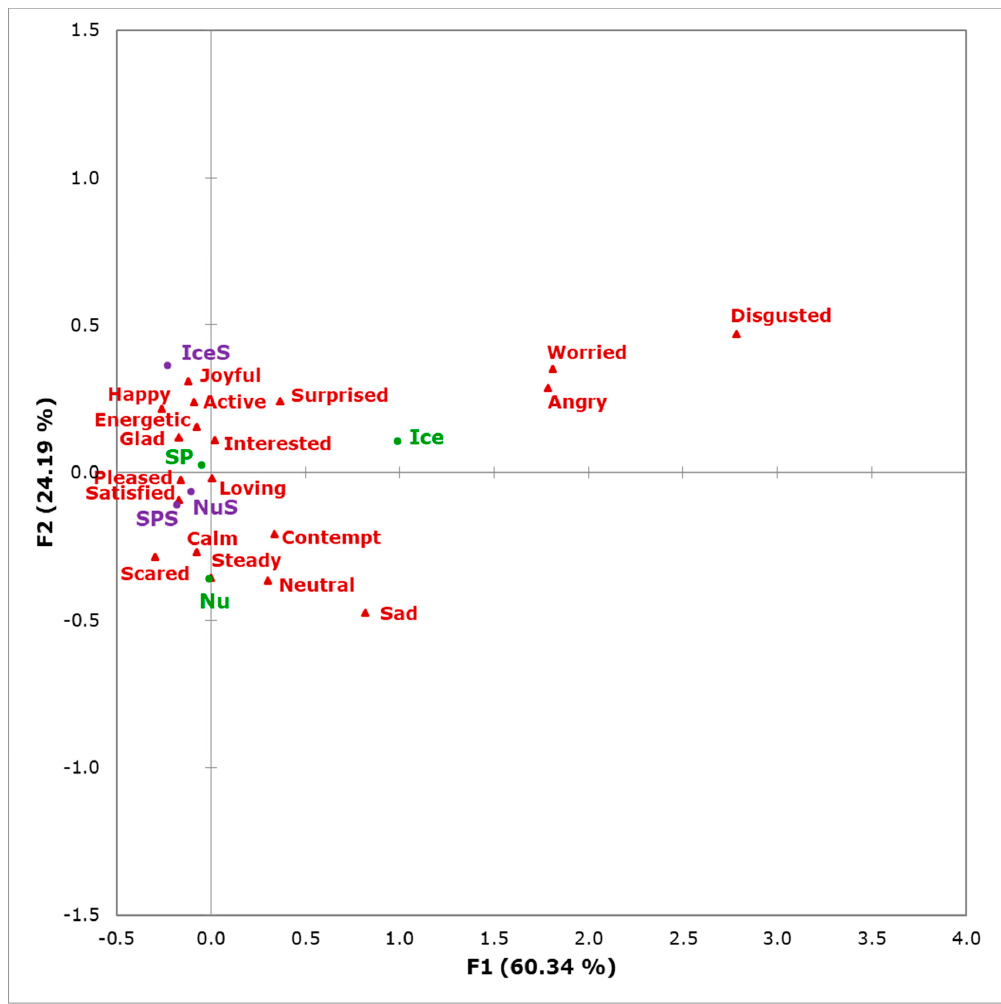
Figure 7. Correspondence analysis of the visual assessment showing the emotion terms in red triangles, and the samples in green circles for the control and purple circles for the sonication treatments. Axes represent the contribution of factors 1 and 2 (F1 and